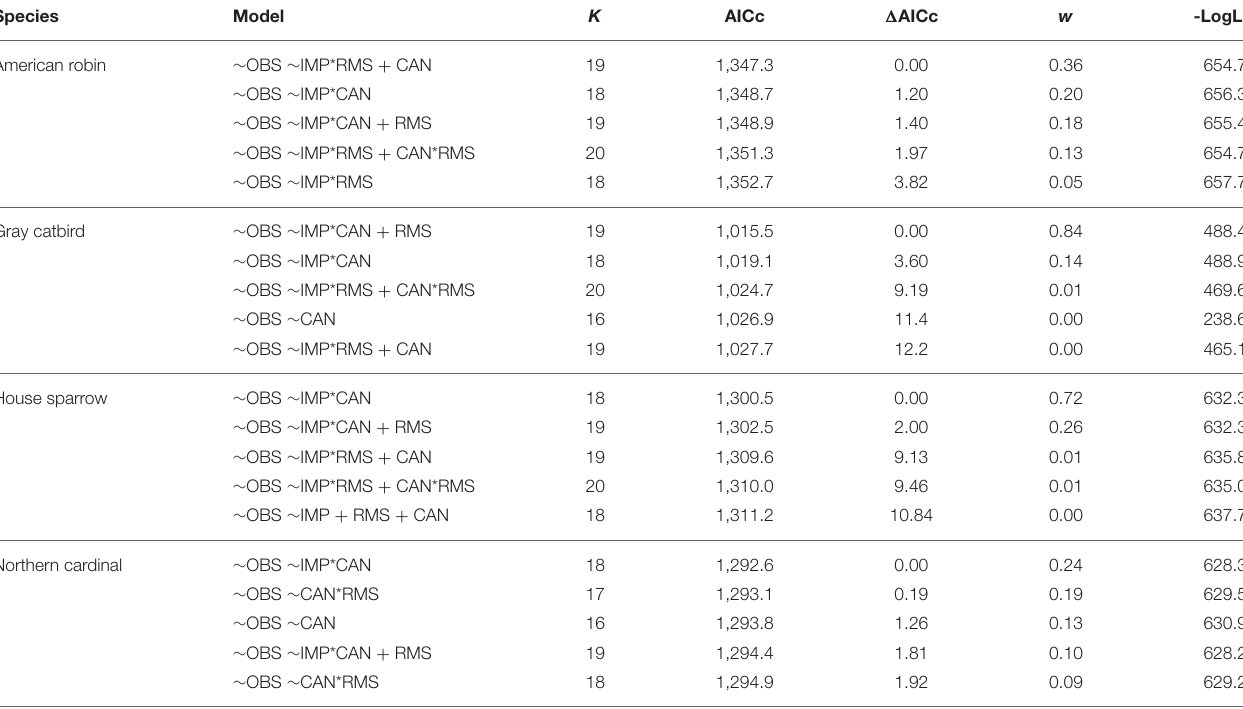
TABLE 2 | Model selection table for distance models used to estimate the abundance of four focal species at sites throughout the Washington D.C. metropolitan region. Species Model K AICc -LogLik American robin